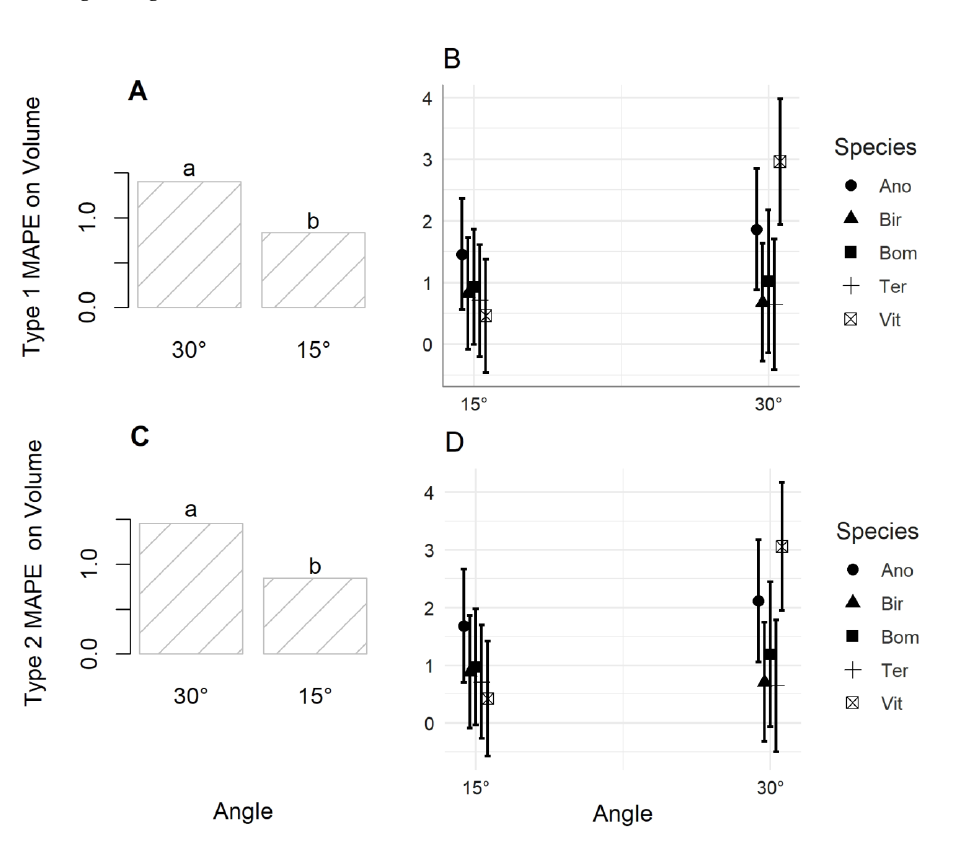
Figure 8. MAPE of stem volume in relation to angular shift ( A , C ) and species ( B , D ). Ano: Anogeissus leiocarpa ; Bom: Bombax costatum ; Bir: Sclerocarya birrea ; Ter: Terminalia laxiflora ; Vit: Vitellaria paradoxa. Histogram bars with different letters (a and b) are significantly different (Waller-Duncan test, p < 0.05).